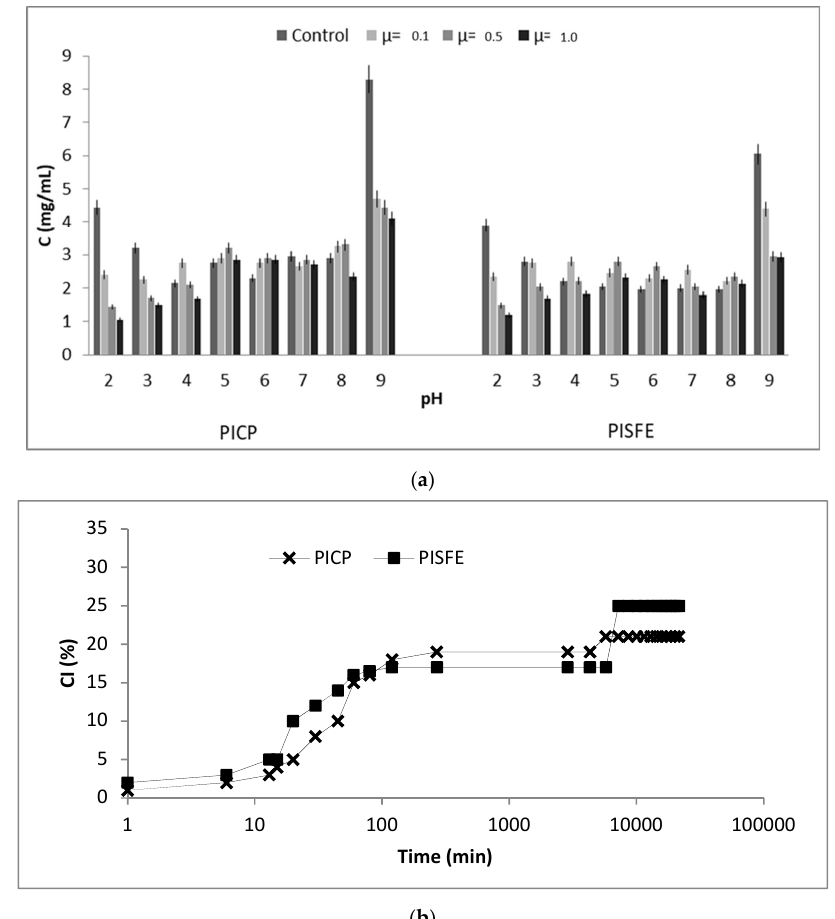
Figure 1. ( a ) Influence of pH and ionic strength (µ) on protein solubility of protein isolates of apricot oil cake protein isolates obtained by cold pressing (PICP) and supercritical fluid extraction (PISFE). Values represent the mean±standard deviation (SD) of n = 3 replicate analysis; ( b ) Creaming index of protein isolates obtained by cold pressing (CP) (×) and supercritical fluid extraction (SFE) ( ■ ) stabilized emulsions during 14 days of storage.